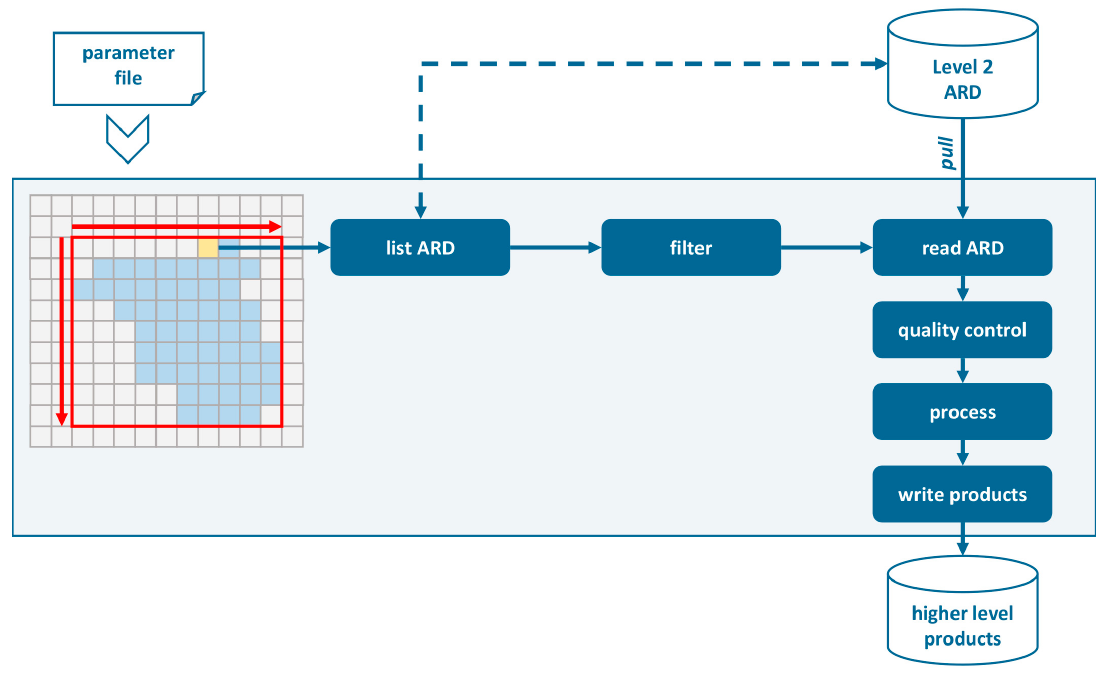
Figure 6. General concept of higher-level FORCE processing.